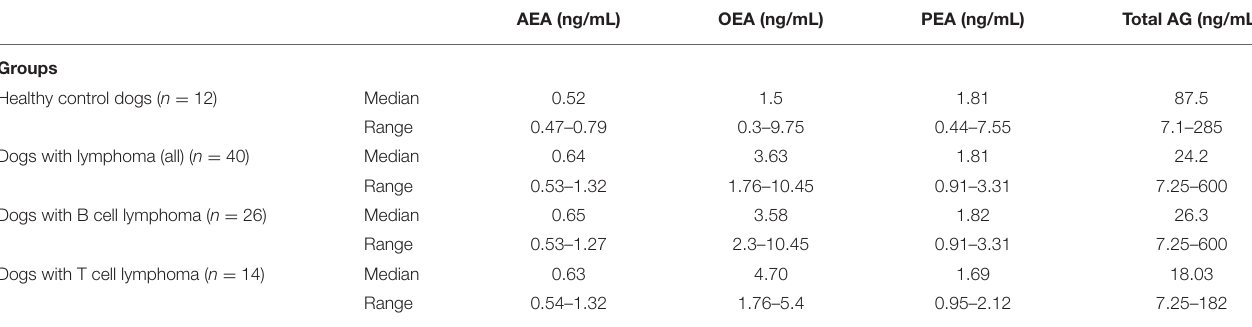
TABLE 3 | Serum AEA, OEA, PEA, and total AG measured in the control and lymphoma